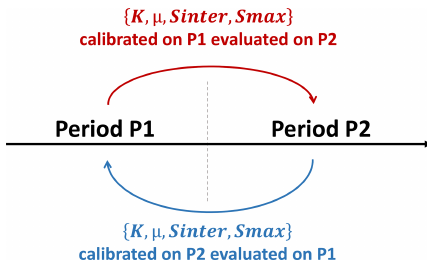
Figure 3. Functional diagram of the split-sample